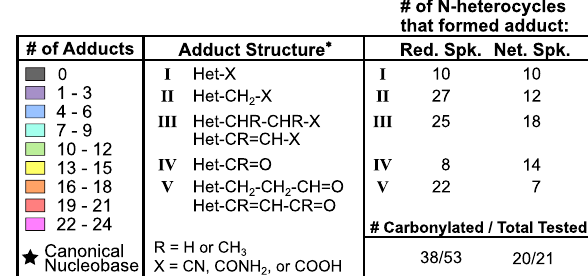
Figure 2. The reactivity of N-heterocycles when incubated with a Miller-Urey spark discharge mixture formed under a reducing (i.e. Red. Spk.) or neutral (i.e. Net. Spk.) atmosphere. Heterocycles are annotated by both their reactivity (background colors) and by which of the most common carbonyls they form (listed as I-V in the legend). Products of hydrolysis (e.g. CN/CONH 2 /COOH) were counted as a single adduct. * Structures I-V are assignments based on accurate mass measurements (typically < 5 ppm error). Note [ 22 , 25 , 31 , and 51 ] were not ionized by the DART source and may be more reactive than shown. For compound names and a complete list of corresponding adducts, see Supplementary Tables S3 and